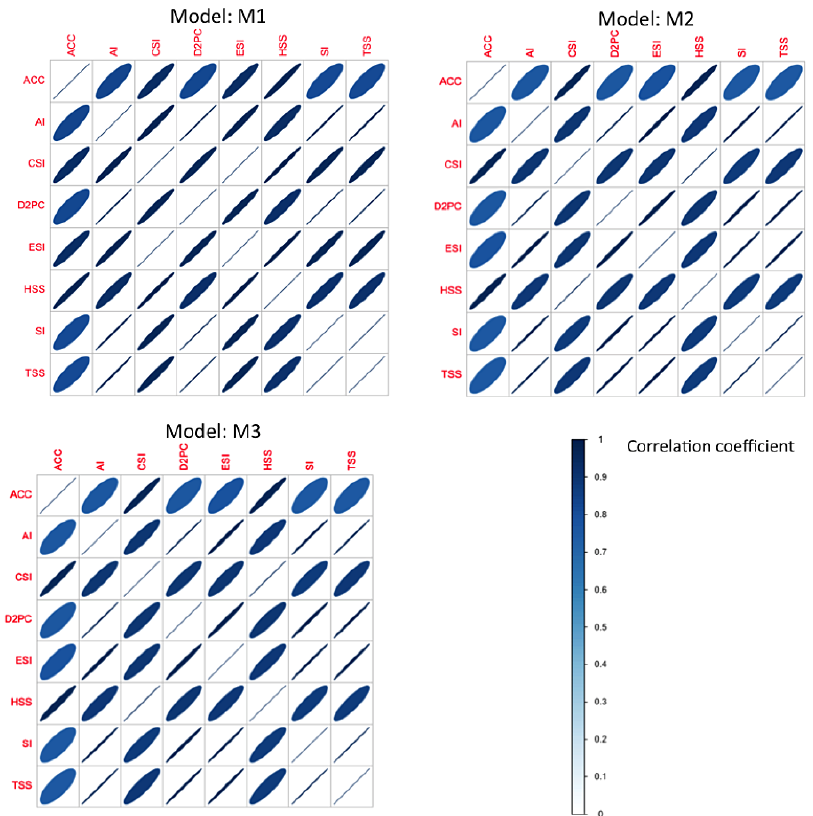
Figure 4. Correlation plot between models’ performance (MP) vectors computed by optimizing all GOF indices in turn. Results are reported for each model: M1, M2, and M3.